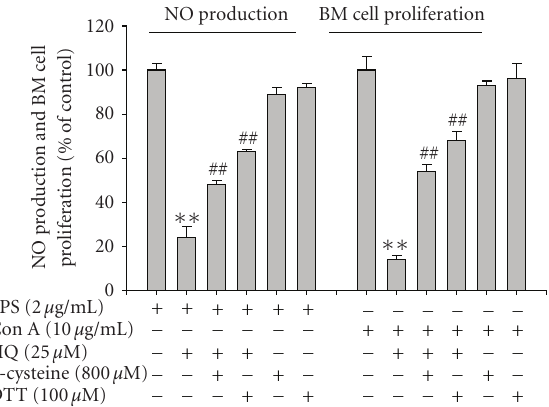
LPS (2 μ g/mL) Con A (10 μ g/mL) HQ (25 μ M) − − − L-cysteine (800 μ M) − −− Figure 10: E ff ect of thiol-containing compounds on hydroquione- mediated inhibition of NO production and lymphocyte prolifera- tion. (a) RAW264.7 cells (1 × 10 6 ) were pretreated with L-cysteine (800 μ M) or DTT (100 μ M) and HQ (hydroquinone, 25 μ M) in the presence or absence of LPS (2.5 μ g/mL) for 24 hours. The level of NO was determined by Griess reagent as described in Section 2. (b) Bone marrow-derived cells were incubated with L- cysteine (800 μ M) or DTT (100 μ M) and hydroquinone (25 μ M) in the presence or absence of Con A (1 μ g/mL) for 24 hours. ∗∗ p < . 01 and ## p < . 01 represent significant di ff erence as compared to control or HQ-treated